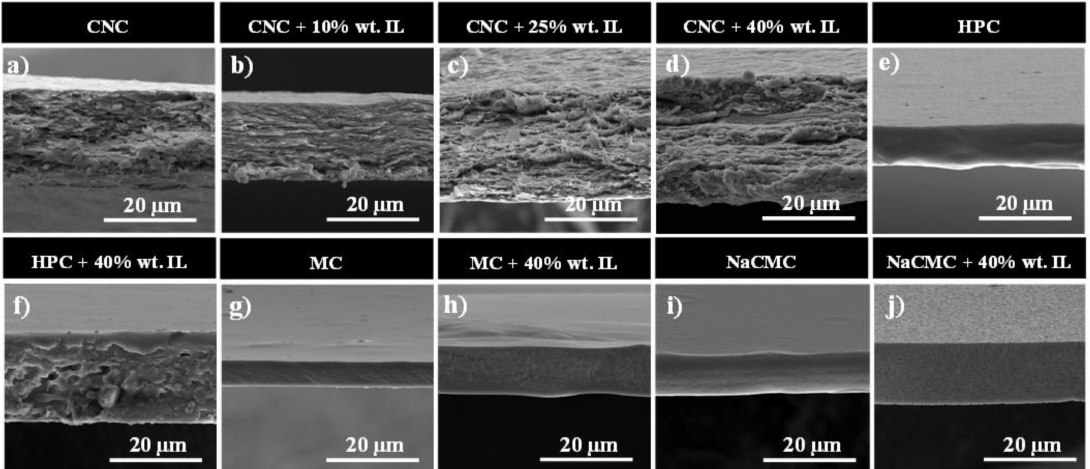
Figure 2. Scanning electron microscope (SEM) images of: ( a ) pure cellulose nanocrystals (CNC); ( b ) CNC + 10% wt. ionic liquid (IL); ( c ) CNC + 25% wt. IL; ( d ) CNC + 40% wt. IL; ( e ) pure HPC; ( f ) hydroxypropyl cellulose (HPC) + 40% wt. IL; ( g ) pure methyl cellulose (MC); ( h ) MC + 40% wt. IL; ( i ) pure sodium carboxymethyl cellulose (NaCMC); and ( j ) NaCMC + 40% wt.